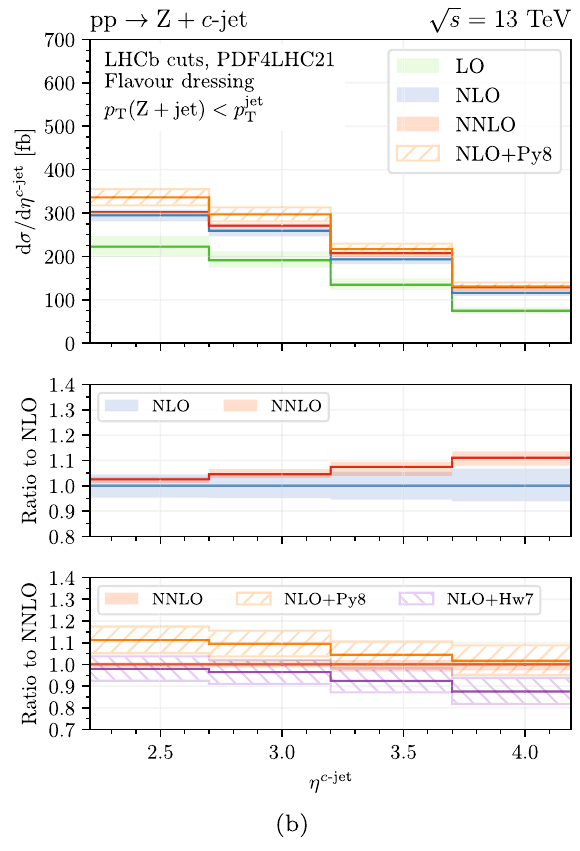
Fig. 2 Comparison of parton-level predictions for the leading flavoured jet pseudo-rapidity η c -jet in the Z + c -jet process: fixed-order predictions at LO (green), NLO (blue) and NNLO (red); NLO+PS pre-